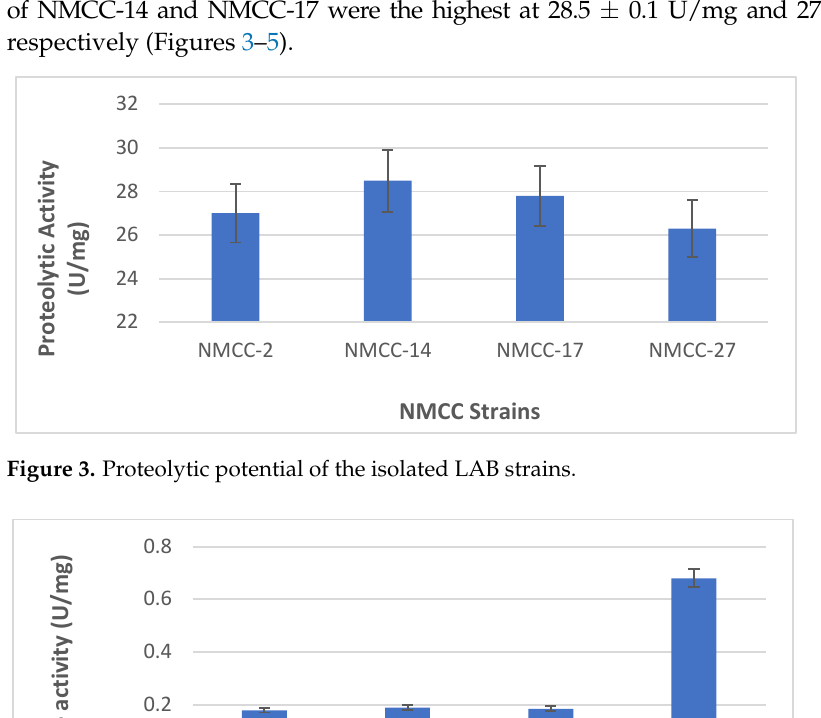
Figure 2. Evaluation of different physiological properties of LAB strains. In vitro values ( n = 3) are mean ± standard deviations. Different subscripts lowercase letters indicate significant differences ( p < 0.05).